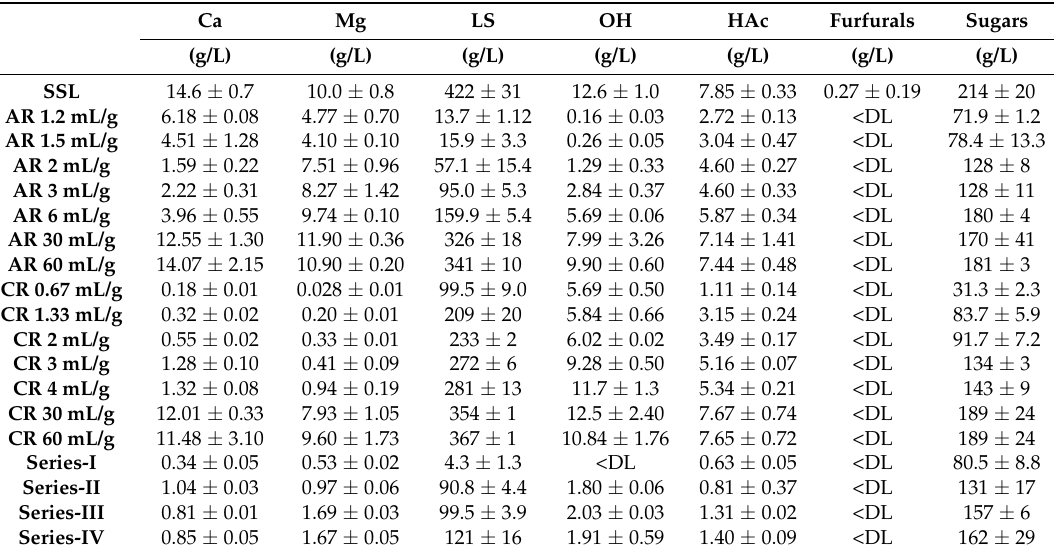
Table 2. Ion exchange resin